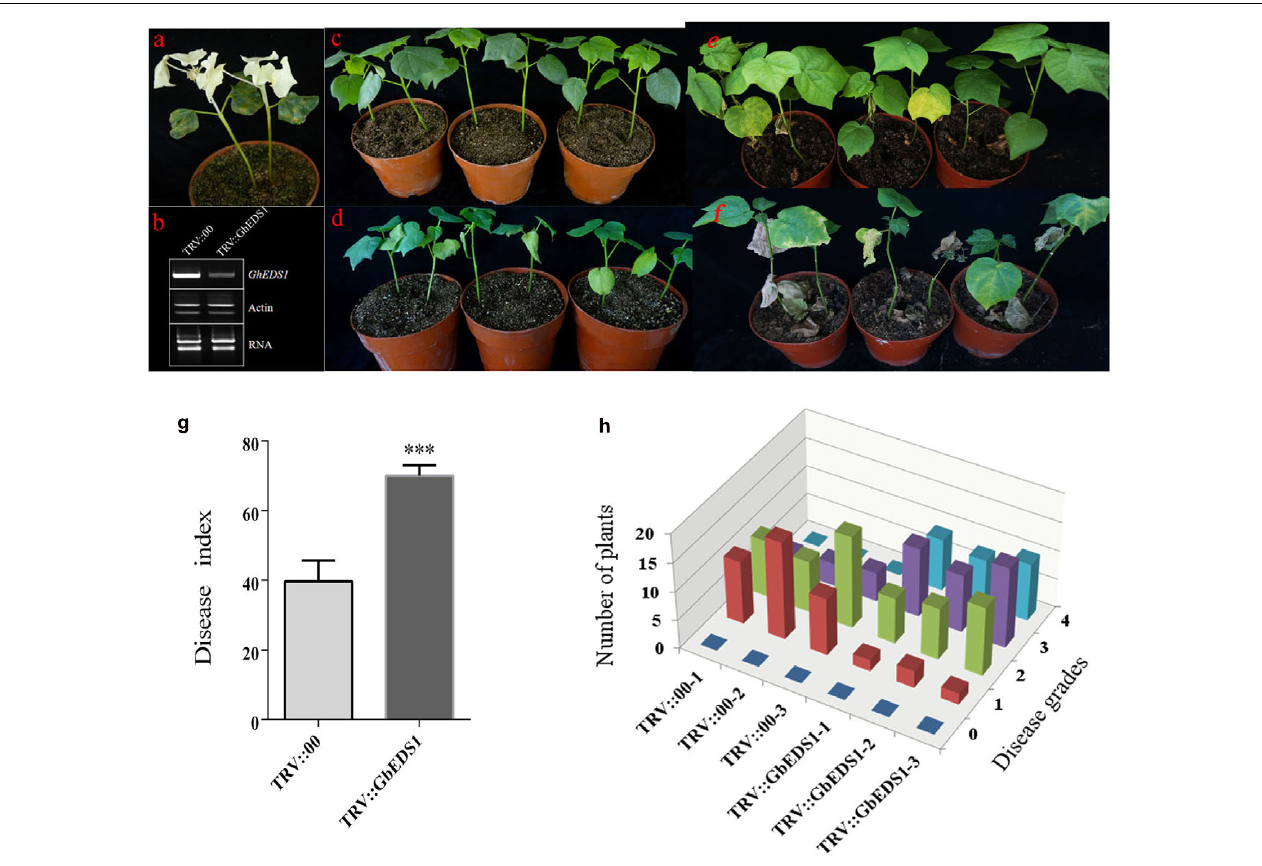
FIGURE 6 | Silencing of GbEDS1 resulted in enhancing susceptibility in cotton against V. dahliae . (a) Disease symptoms induced on TRV:00, TRV:GbEDS1 seedlings after inoculation with V. dahliae . Ten-day-old G. barbadense cv. Pima90-53 seedlings were hand-infiltrated with Agrobacterium carrying target gene in the VIGS vector. Two weeks after infiltration, the seedlings were dip-inoculated with V. dahliae . Photos were taken at 14 and 28 days post inoculation. (b) qPCR analysis of the GbEDS1 transcripts in control and silencing seedlings. Disease symptoms inoculated with V. dahliae strain on TRV::00 (c,e) and TRV::GbEDS1 (d,f) plants. (g,h) The rate of diseased plants and disease index were measured at 20 dpi. Error bars represent the standard deviation of three biological replicates ( n ≥ 30); asterisks indicate statistically significant differences, as determined by the Student t -test ( ∗∗∗ P <